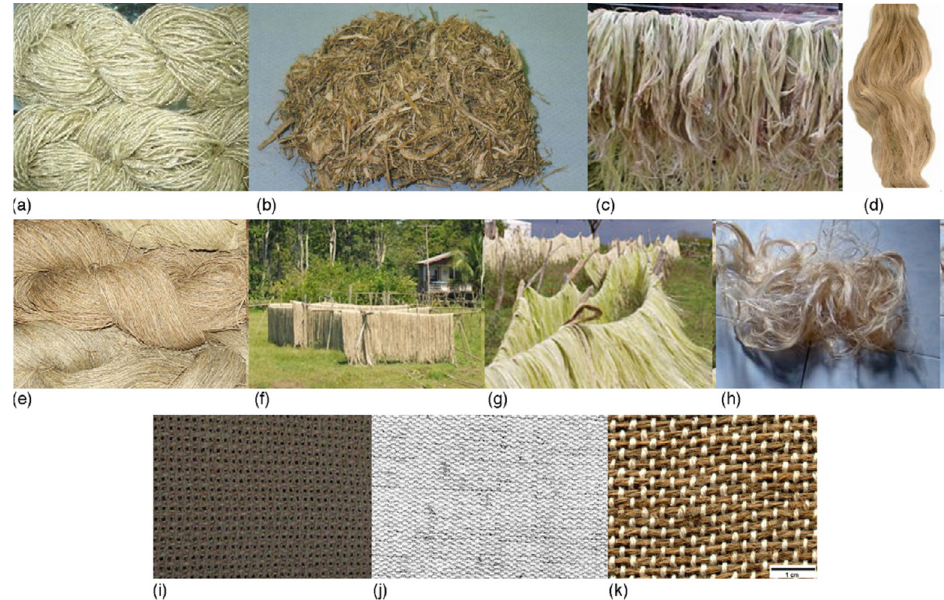
Figure 3. Examples of lignocellulosic reinforcement materials including. ( a ) banana stem fibers; ( b ) sugarcane bagasse; ( c ) curauá; ( d ) flax; ( e ) hemp; ( f ) jute; ( g ) sisal; and ( h ) kenaf. Typical reinforcement patterns used in hybrid LC-based biodegradable composite synthesis. ( i ) Jute fabric; ( j ) ramie–cotton fabric. ( k ) jute–cotton fabric. [40].